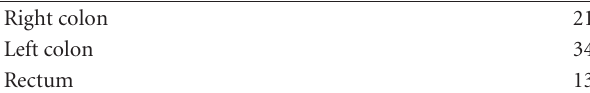
Table 2: Site of primary tumour.